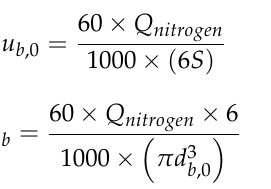
Table 6. Comparison of the mixing time for saturated KCl solution between the physical and numerical modelings. Blowing Mode Dual bottom plugs Dual side plugs at 116 mm Three side plugs at 116 mm Four side plugs at 116